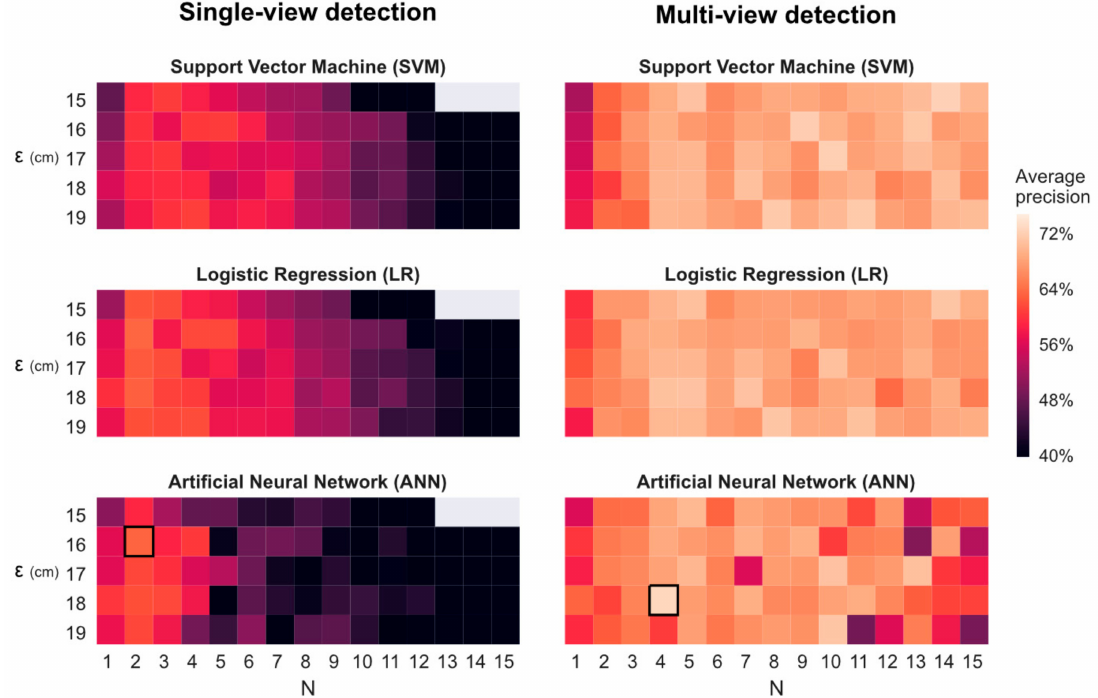
Figure 8. Average precision of detection for different cluster classifiers, as a function of clustering parameters. Multiview outperforms single-view for any given combination of clustering parameters. The optimal clustering parameter configurations are highlighted with a black outline. Grey areas indicate where clustering parameters were too exclusive for classification to